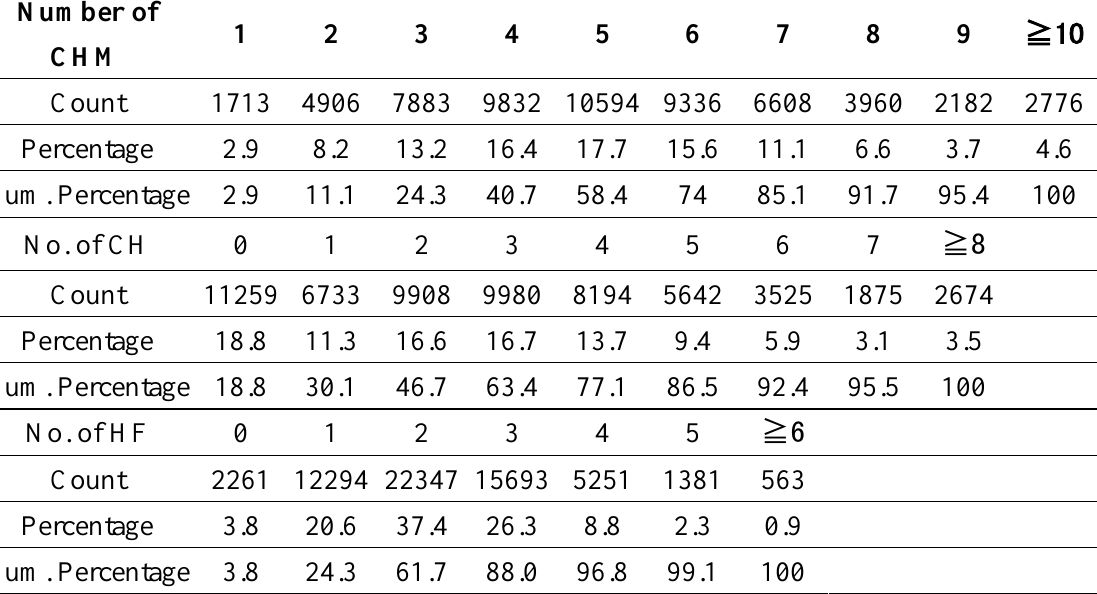
Table 1. Number of Chinese herbal medicine (CHM) drugs per prescription.